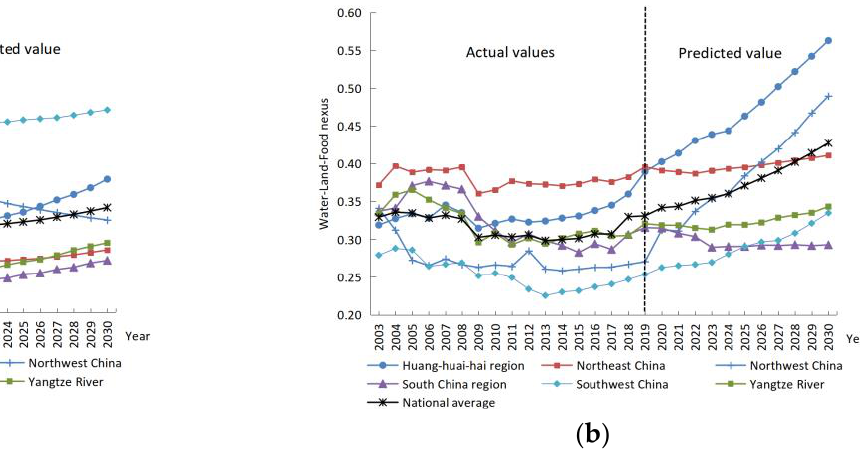
Figure 3. Regional characteristics and growth rate forecast of decentralized food crop cultivation and WLF nexus, 2003 – 2030. ( a ) 2003 – 2030 decentralized food crop cultivation; ( b ) 2003 – 2019 WLF